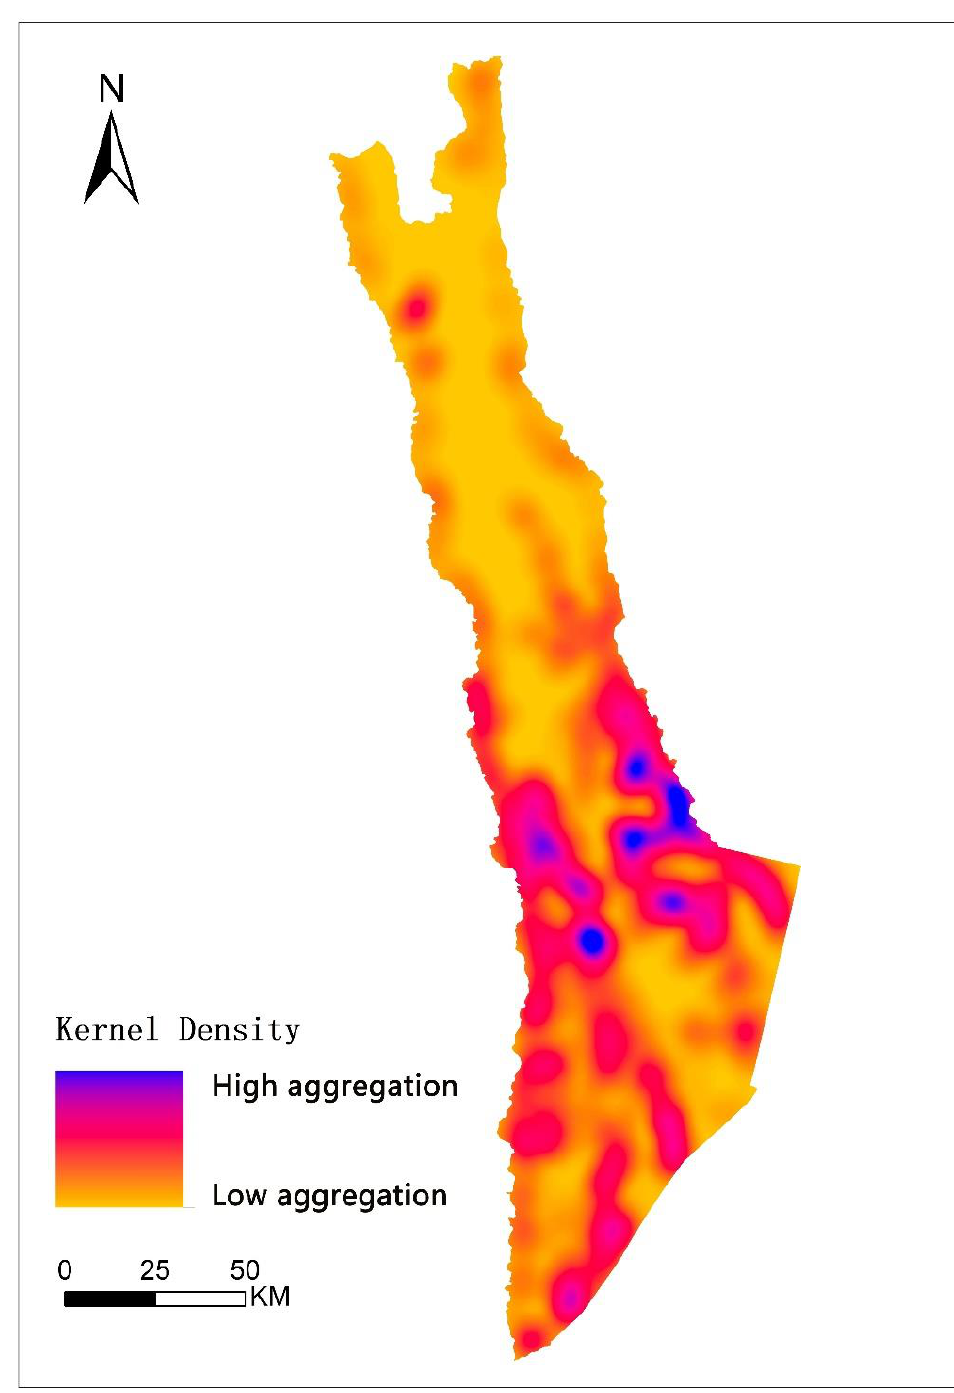
Figure 3. Distribution of kernel density in Northwest Yunnan.